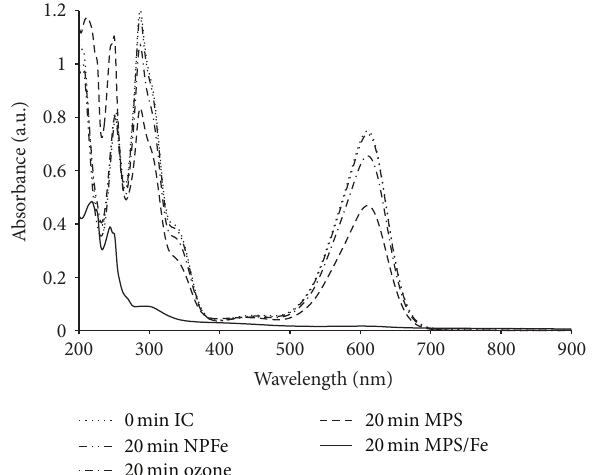
Figure 2: Effect of the addition of unsupported and supported iron particles on UV-Vis spectra of indigo carmine solution after 20 minutes of ozonation.